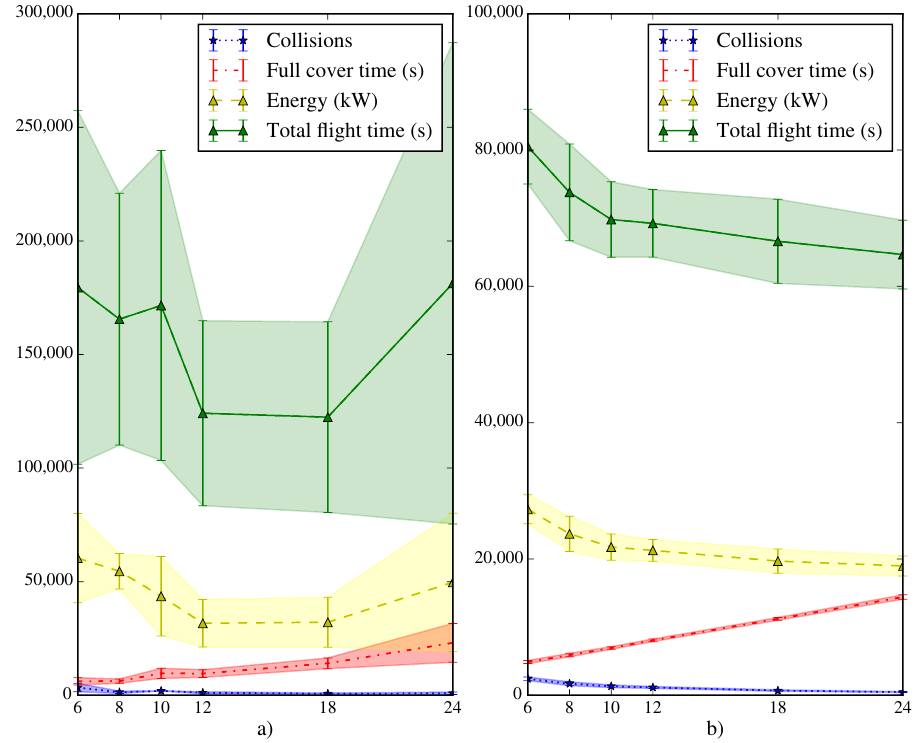
Figure 15. Results of the SLABE ( a ) and SEPHE ( b ) behavior simulations performed on 50 random wall maps. In each simulation, a random start position has been chosen among all feasible locations. Six different take-off time intervals (6, 8, 10, 12, 18, and 24 s) have been tested for each map. The average and standard deviation of the number of collisions, the time required to achieve 95% coverage, the energy consumed by the swarm, and total flight time are